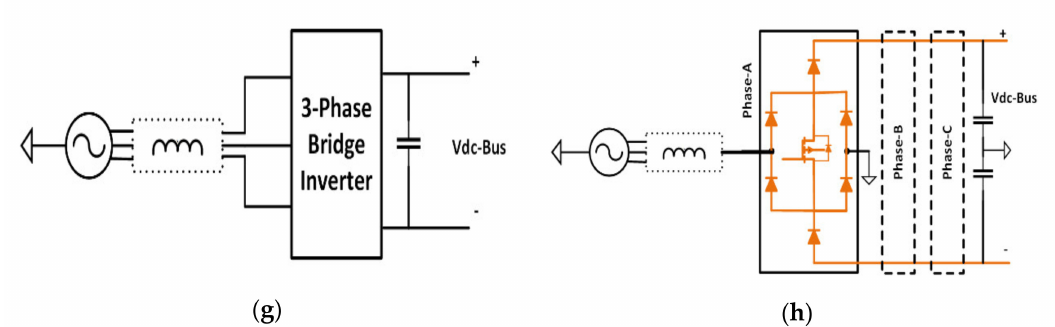
Figure 7. Schematic diagram of bidirectional AC-DC inverter topologies. ( a ) one-phase half-bridge (HB) bidirectional boost inverter; ( b ) one-phase voltage source inverter (VSI) full-bridge (FB) bidirectional boost inverter; ( c ) one-phase one-stage isolated bidirectional inverter with output low pass filter (LPF); ( d ) FB bidirectional inverter with leakage current reduction; ( e ) three-phase FB bidirectional inverter; ( f ) three-level three-phase diode neutral point clamped (NPC) inverter; ( g ) three-phase bridgeless boost inverter; ( h ) three-phase Vienna rectifier [13,34,46,47,56,57,61–64].